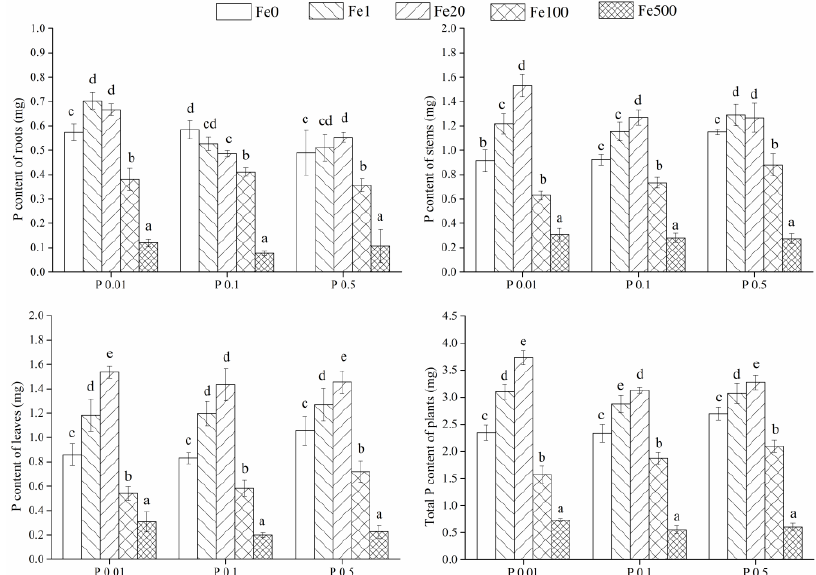
Figure 6. Effects of Fe 2+ and P on roots, stems, leaves and total P contents of G. spiculosa . Values (mean ± SE, n = 3) followed by different letters designate significant differences ( p < 0.05) between Fe 2+ concentrations for a given P level (a, b, c).